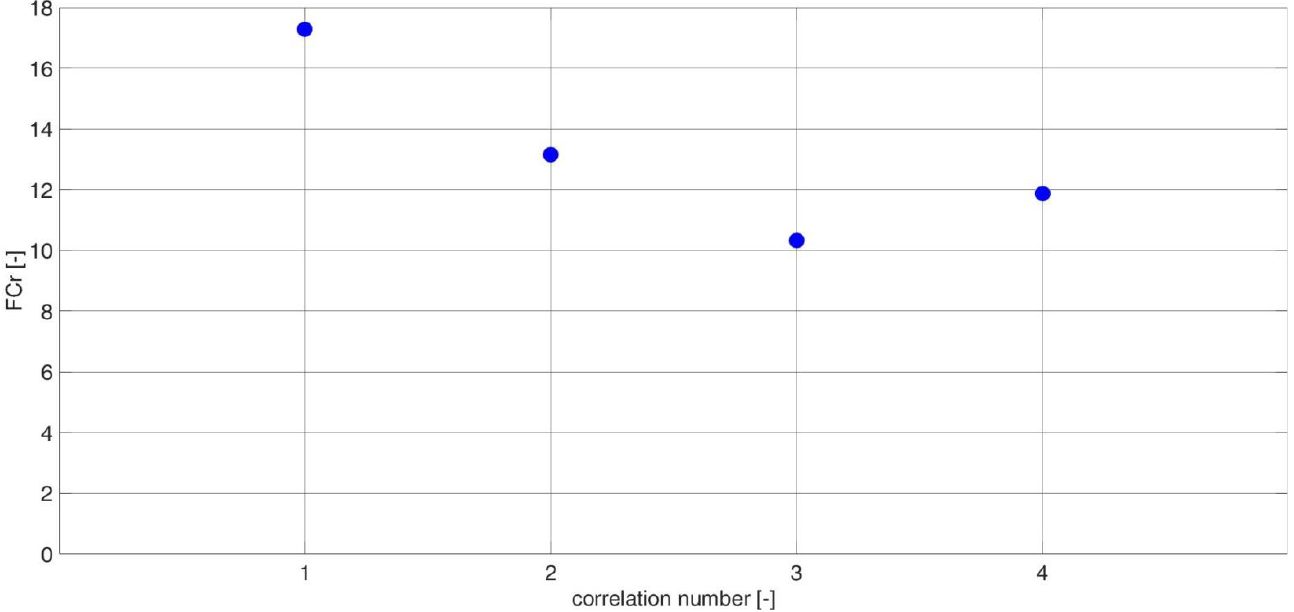
Figure 9. The Fisher criteria for outer race diagnosis via CCSM3, for each correlation number (Table A2).